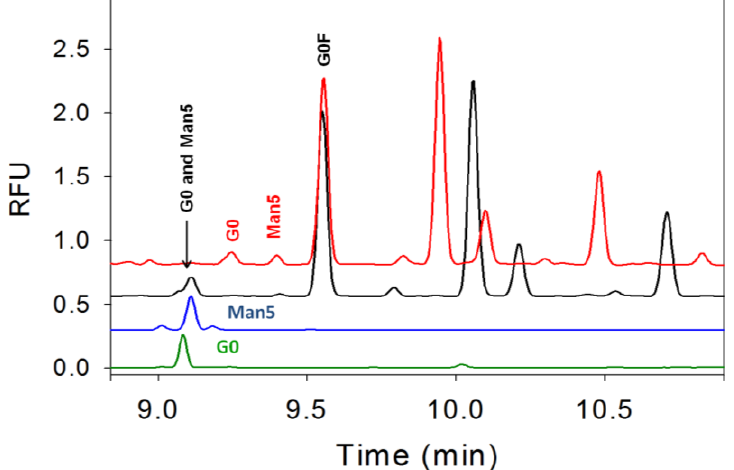
Figure 5. Two glycans, G0 and Man5, co-migrate in the Beckman buffer (black trace). G0 (green trace) and Man5 (blue trace) standards were run separately using the Beckman buffer to confirm the co-migration. An improved separation buffer containing EACA/CH COOH with HPMC was developed and experiments with this buffer show that 3 it was capable of separating G0 and Man5 (red